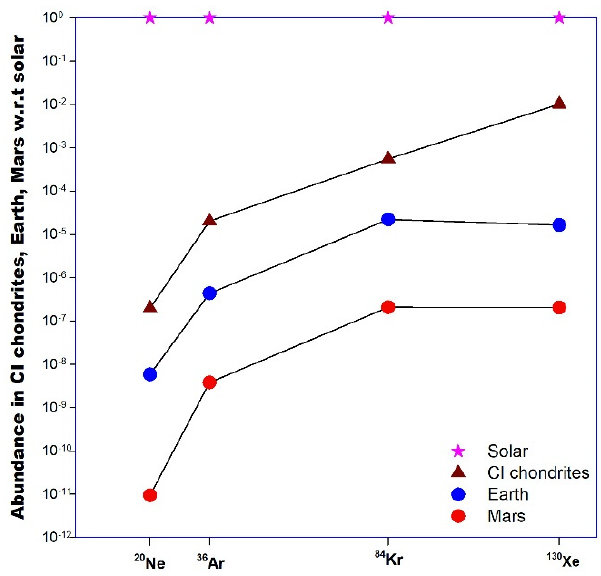
Figure 5. Elemental noble gas abundance patterns of the Earth, Mars, CI meteorites, normalized to solar values. The atmospheres of Earth and Mars are depleted in Xe compared to chondrites.